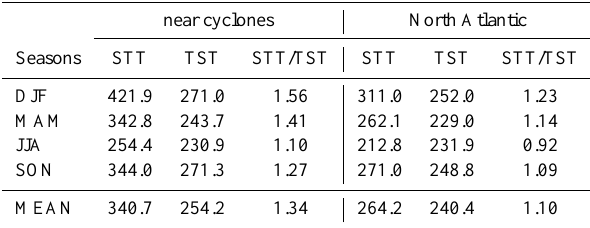
Table 2. Average mass flux (kgkm − 2 s − 1 ) per season from 1979 to 2011 for STT and TST in the vicinity of cyclones over the North Atlantic and the average over the entire North Atlantic as well as the ratio between STT and TST. The minimum lifetime of a cyclone is